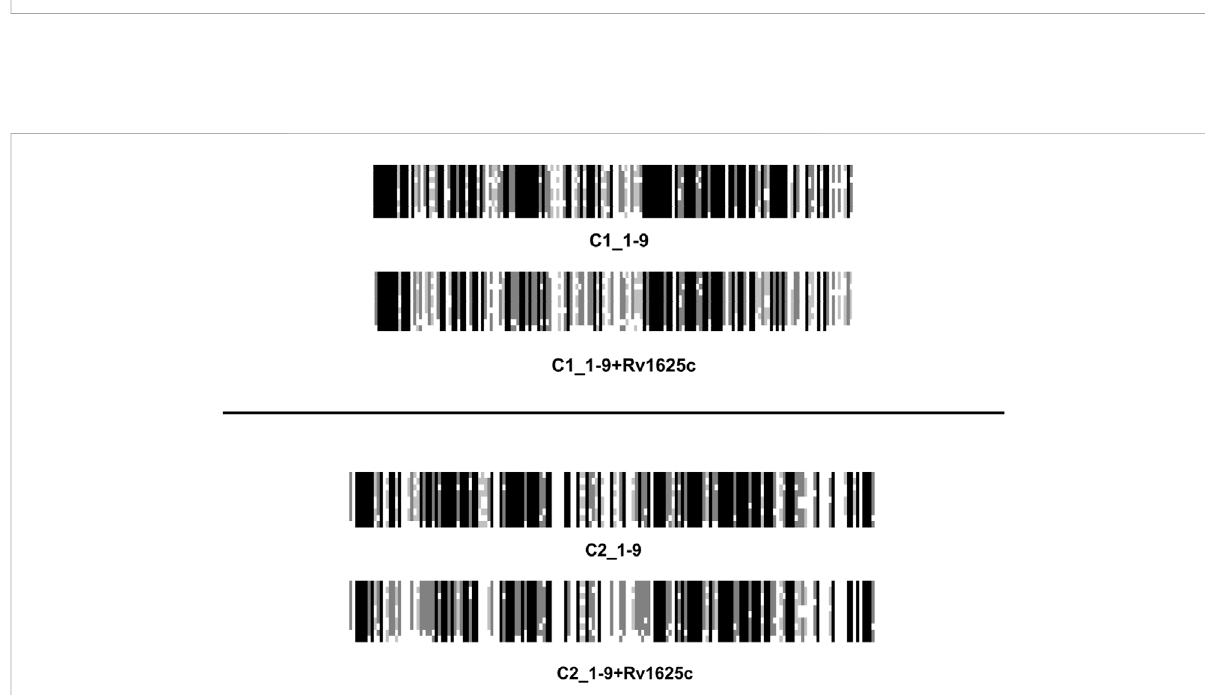
FIGURE 7 An alignment of the C1 and C2 catalytic domains from human adenylyl cyclases isoforms 1 through 9 ± the catalytic domain from the mycobacterial adenylyl cyclase